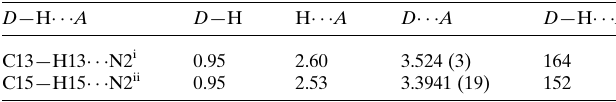
Table 5 Hydrogen-bond geometry (A˚ , (cid:3) ) for 1b .